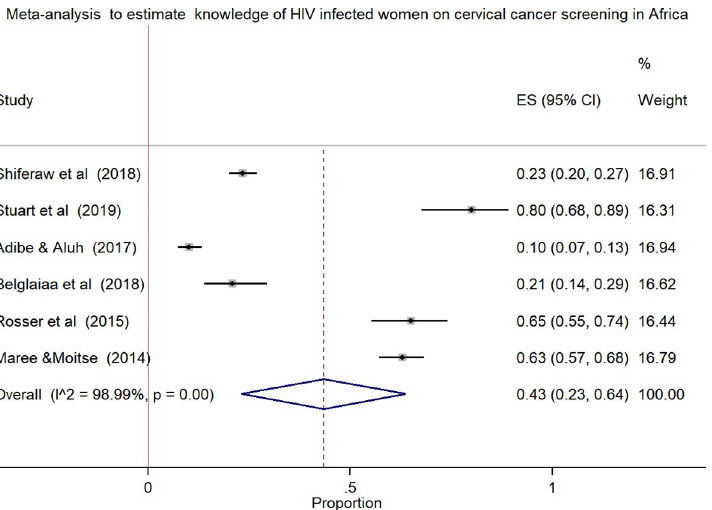
Fig 2. Forest plot to estimates the proportion of knowledge among HIV infected women towards cervical cancer screening in Africa with 95% CI (the estimate weighted based on random effects model): ES-Effect size equivalent to the proportion, CI-Confidence interval. In the plot, the diamond shows the pooled result and the boxes show the effect estimates from the single studies. The purple dotted vertical line indicates pooled estimate. The purple solid vertical line indicates the reference line at zero indicating no effect. The horizontal line through the boxes illustrate the length of the confidence interval and the boxes show the effect estimates from the single studies.